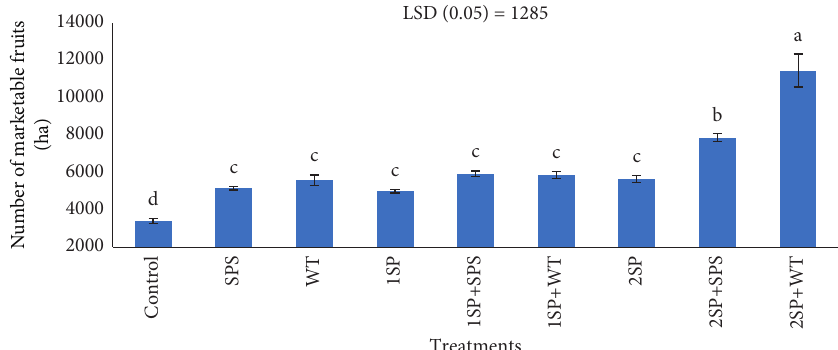
Figure 3: Effect of pruning and staking on number of marketable fruits at harvest. Bars with different letters denote significance at p < 0 . 05. Error bars denote the standard error of means. Means comparison was conducted using the least significant difference ( p < 0 . 05).